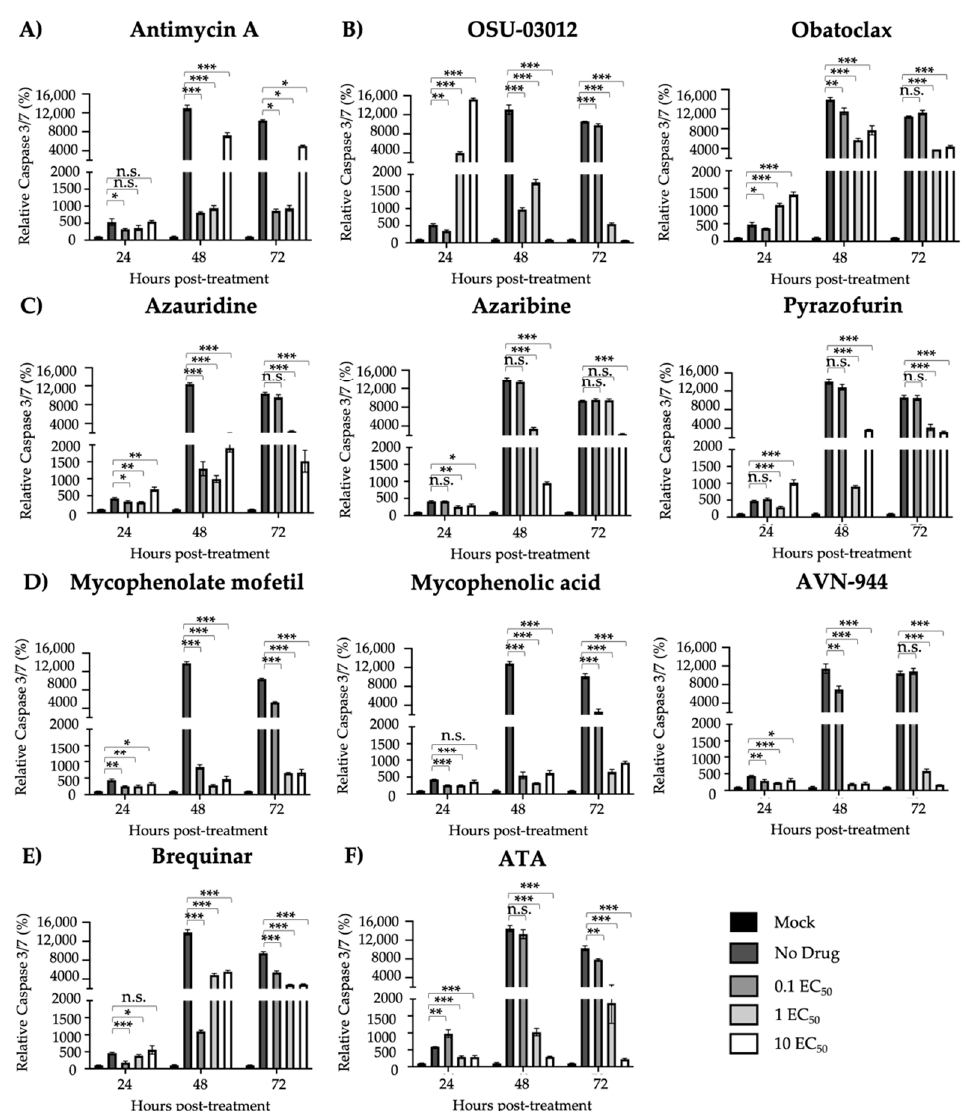
Figure 7. Prevention of apoptosis-induced cell death: Vero cells (24-well plate format, 2.5 × 10 5 cells/well, triplicates) were infected (MOI 0.1) with Paraiba/2015. After 2 h viral absorption, infected cells were treated with the indicated concentrations of compounds (0, 0.1, 1, and 10 EC 50 ) ( A ) Antimycin A, ( B ) OSU-03012 and Obatoclax, ( C ) Azaribine, Azauridine, and Pyrazofurin, ( D ) Mycophenolate mofetil, Mycophenolic acid, and AVN-944, ( E ) Brequinar, and ( F ) Aurintricarboxylic acid (ATA); and Caspase 3/7 levels were measured at 24, 48, and 72 h post-treatment. Data of each time point was compared to mock-infected control cells and expressed as mean of relative percentage and SD from three independent experiments conducted in triplicates. Statistical analysis was conducted by an unpaired Student’s t -test, * p < 0.05, ** p < 0.01, *** p < 0.001, or no significance (n.s.).